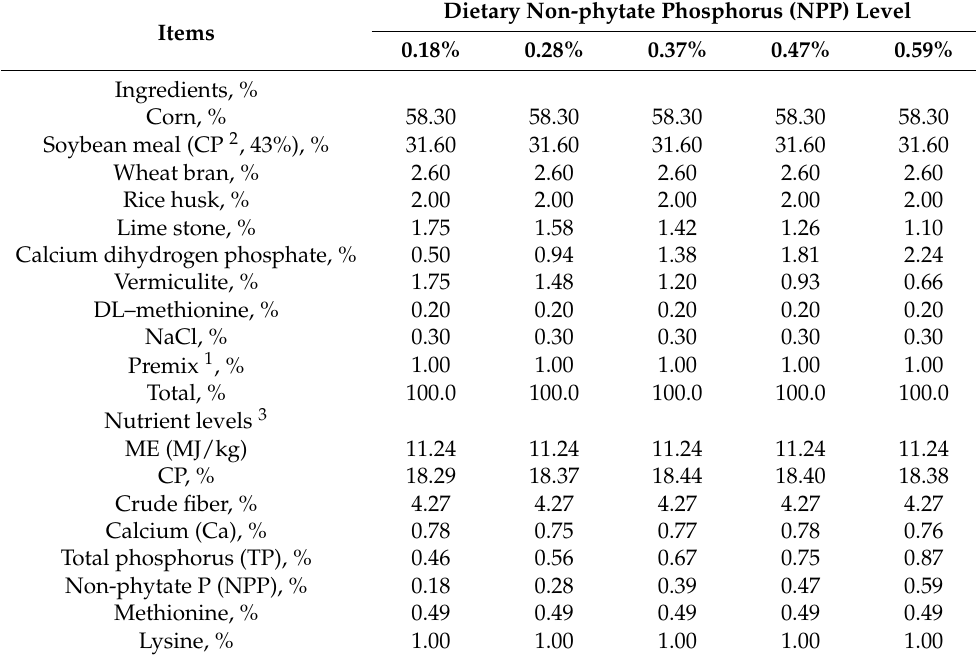
Table 1. Composition and nutrient levels of experimental diets (air-dry basis). Dietary Non-phytate Phosphorus (NPP) Items